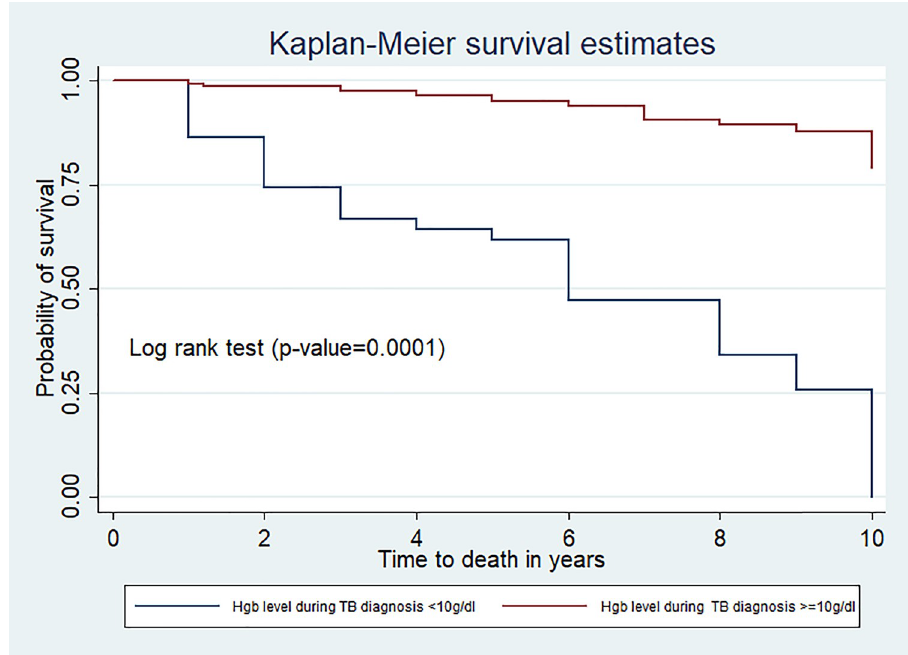
Fig 2. Kaplan Meier survival estimates of hemoglobin level at TB diagnosis among TB/HIV co-infected children at public hospitals, Southern Ethiopia.